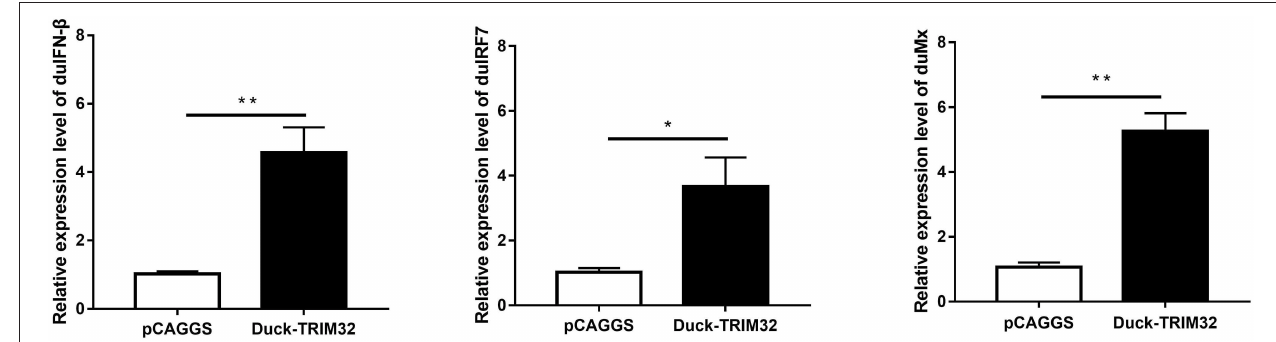
FIGURE 6 | The DEFs respond to overexpression of the duTRIM32. The DEFs (6 wells) were transfected with pCAGGS-duTRIM32-V5 (2 µ g/well) or empty vector (2 µ g/well). The relative expression of IFN β , IRF7, and Mx genes were detected by real-time RT-PCR. All data were expressed as means ± SD, the Student’s t -test was used to analyze the differences. (* p < 0.05; ** p < 0.01).